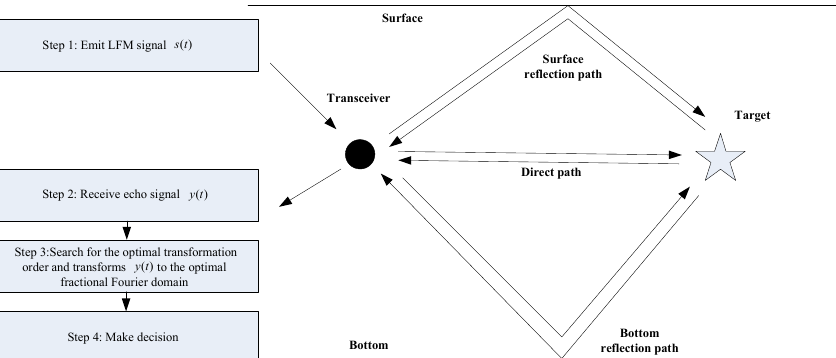
Figure 1. The schematic of Fractional Fourier transform (FrFT) detection. The traditional FrFT detection method has four